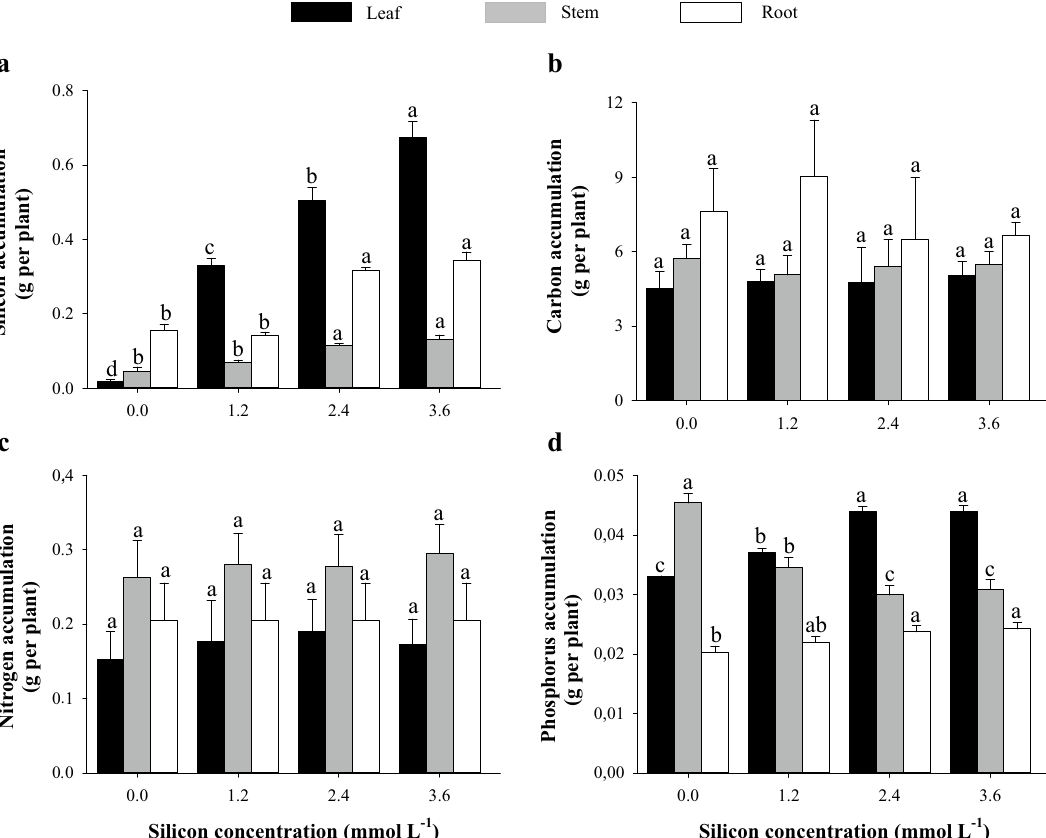
Figure 2. Accumulation of silicon (Si) ( a ), carbon (C) ( b ), nitrogen (N) ( c ), and phosphorus (P) ( d ) in different parts of grain sorghum plants under different Si concentrations. Error bars over the dots indicate the standard error of the mean. *, **, and ns—significant at 1%, at 5%, and not significant by the F test,